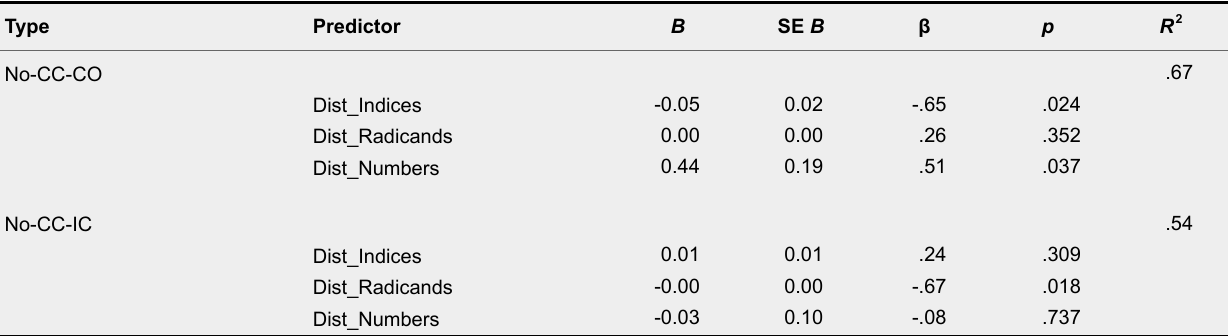
Results of the Multiple Linear Regression Analyses With Numerical Distances as Predictors and Sample Mean Accuracy as the Depending Variable, for Each Type of